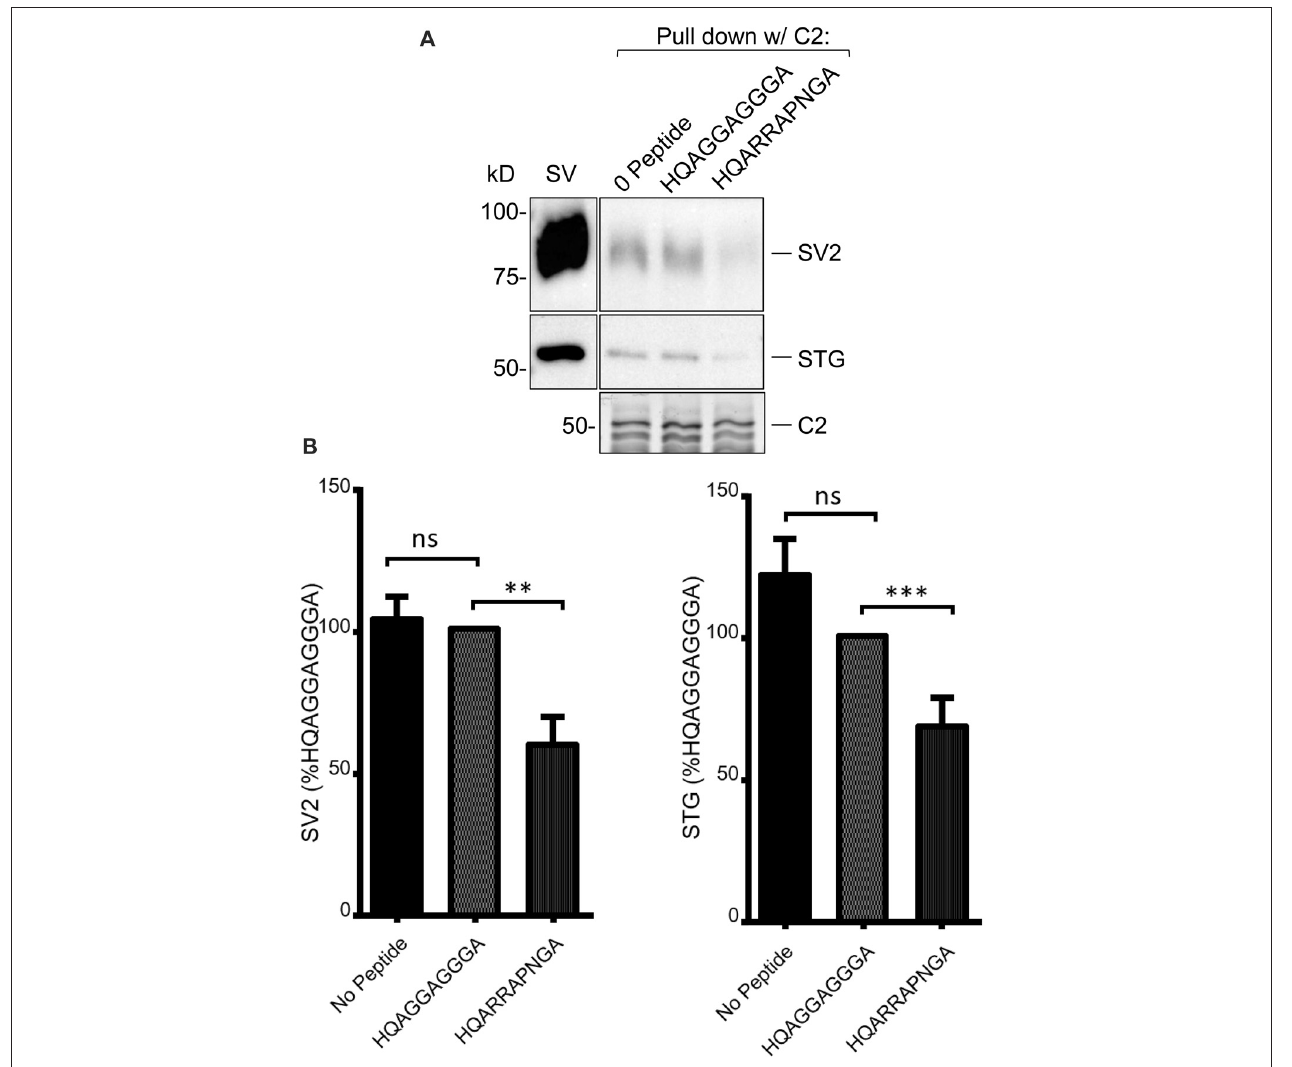
FIGURE 4 | (A) SV-PD with C2 is inhibited by (+)xxRR motif mimetic blocking peptide. (B) Left panel : SV-PD with C2 fusion protein as in Figure 4A after no treatment (0 peptide) or pretreatment of the SV sample with control, HQAGGAGGGA, or motif-blocking peptide, HQARRAPNGA. Note the marked inhibition of SV protein capture with the blocking peptide. (B) Right panel : histograms comparing SV or STG protein band intensity for no peptide, control peptide and blocking peptide conditions. ∗∗ p < 0.01; ∗∗∗ p < 0.001; ns p > 0.1.